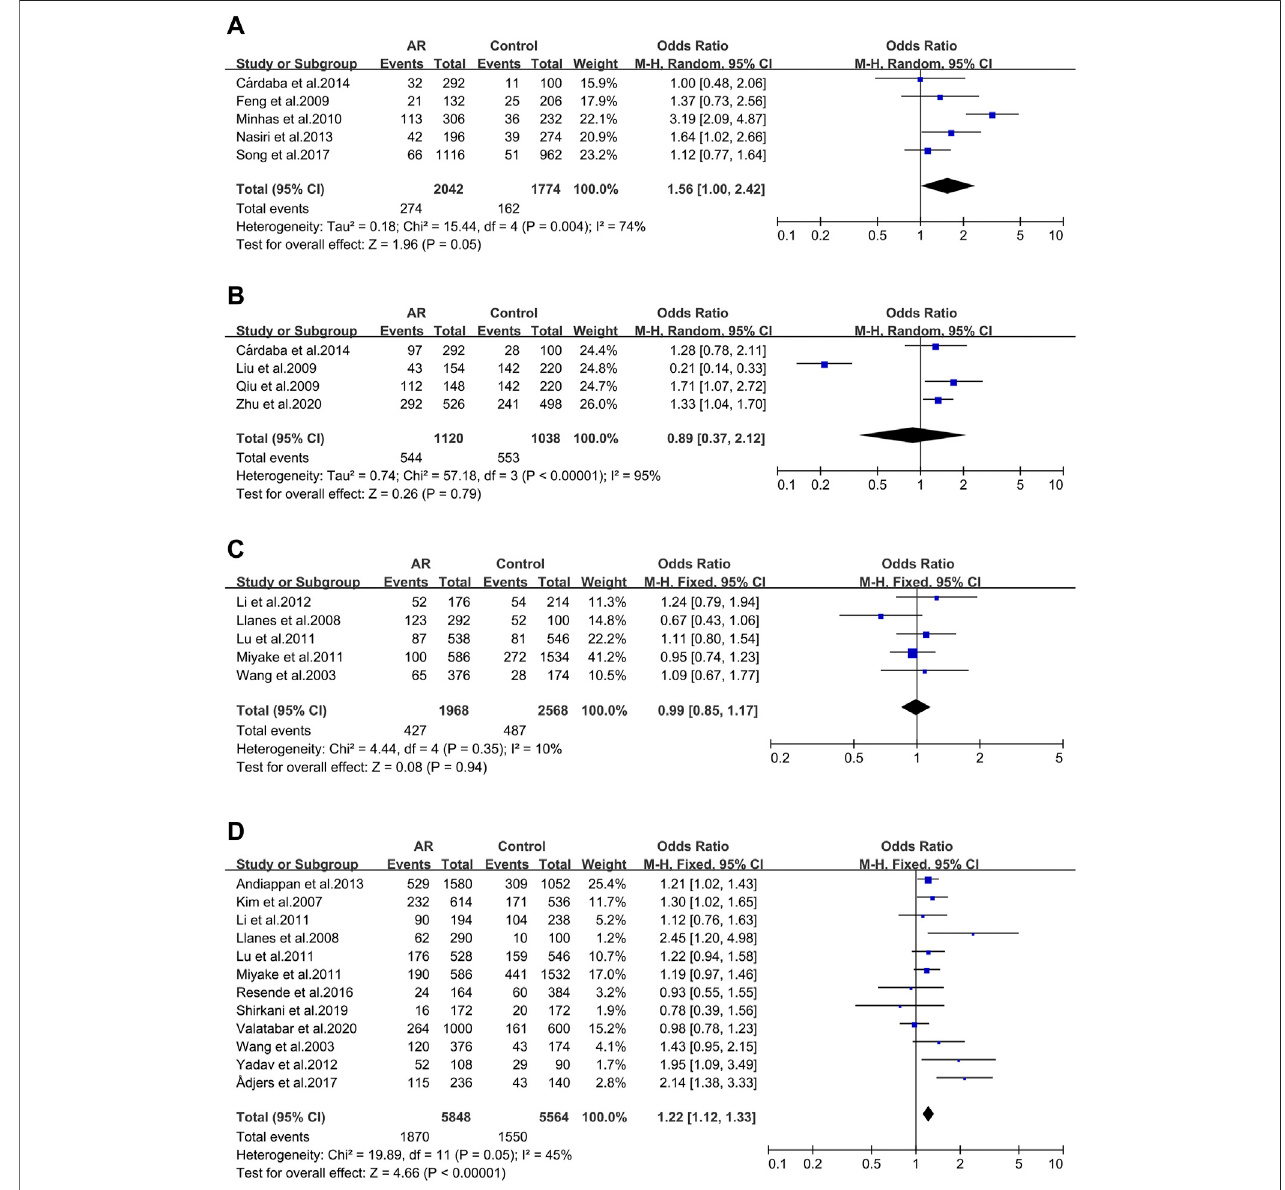
FIGURE2| ForestplotsforTNF α ,TGF β 1andIL-13polymorphisms. (A) TNF α (rs1800629):Aallele; (B) TGF β 1(rs1800469):alleleG; (C) IL-13(rs1800925):alleleT; (D) IL-13 (rs20541): allele A.